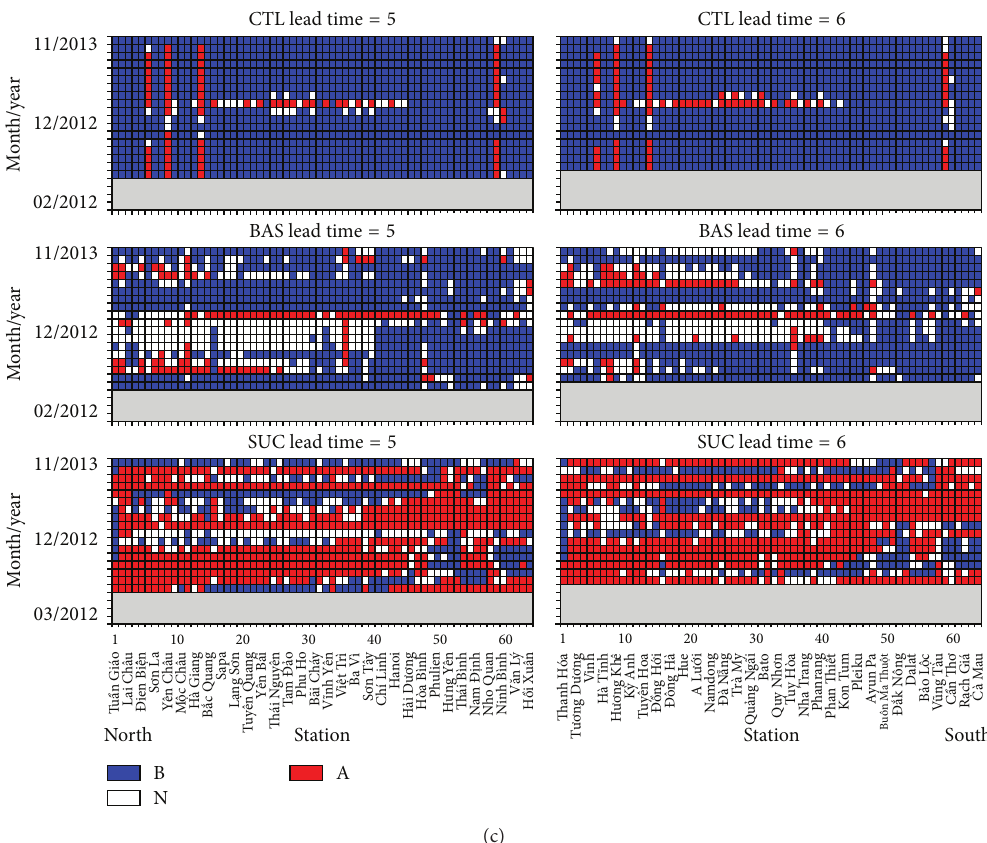
Figure 7: (a) Forecast tercile probabilities of T2m at 64 stations for lead times of 1 and 2 months for the CTL (top), BAS (middle), and SUC (bottom) experiments. Vertical axis indicates the target months. The numbers in horizontal axis indicate 64 stations in the order from North to South. The names of stations in the corresponding order are placed at the bottom of the figure. B (blue), N (white), and A (red) indicate below-normal , normal , and above-normal probabilities, respectively. (b) Same as (a) but for lead times of 3 and 4 months. (c) Same as (a) but for lead times of 5 and 6